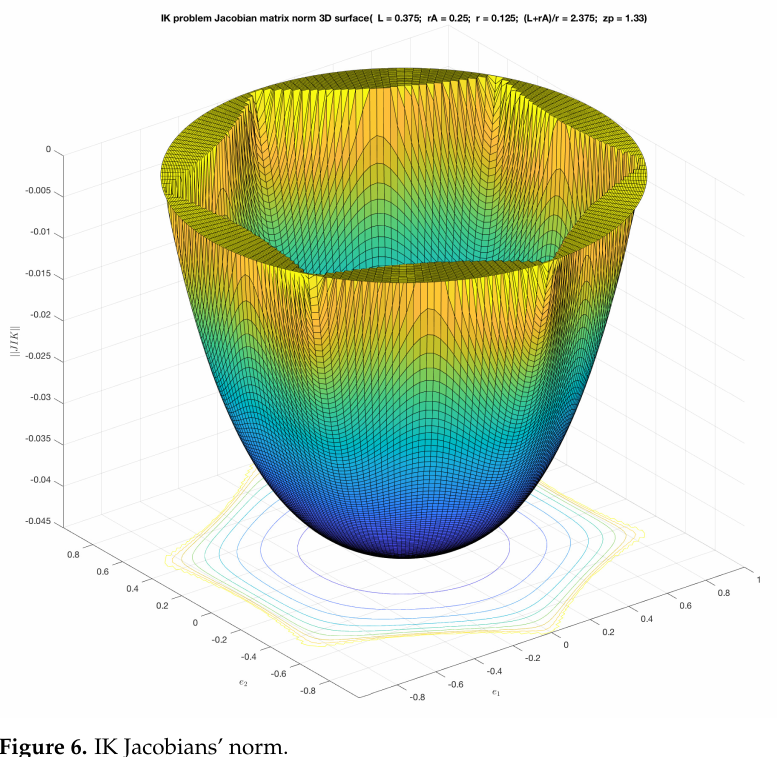
Figure 6. IK Jacobians’ norm.